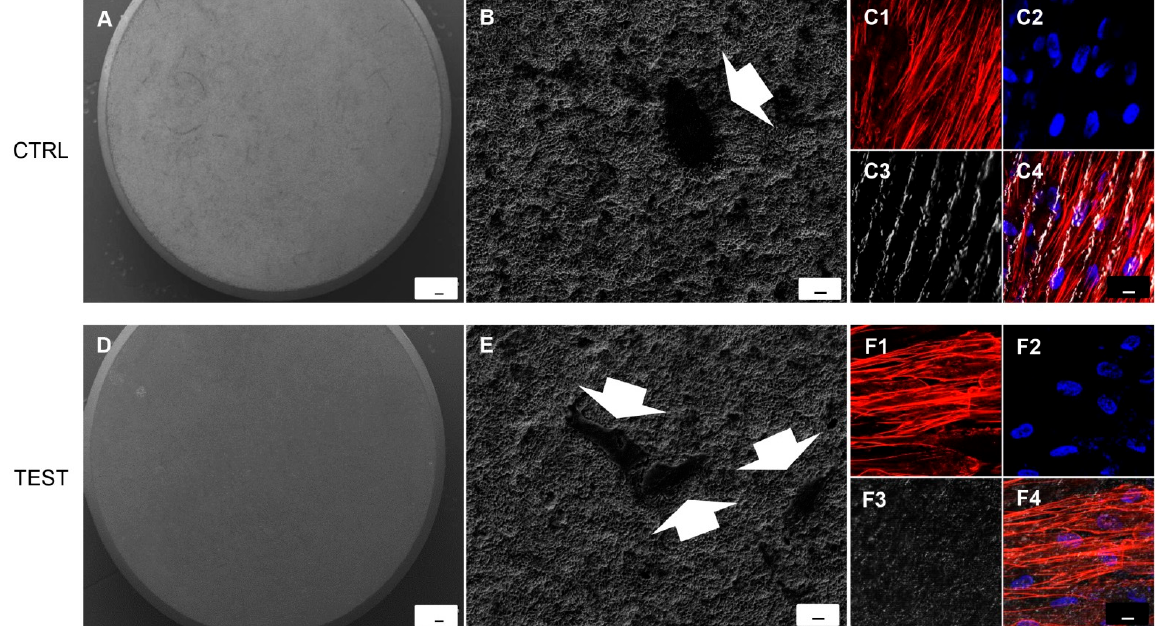
Figure 2. SEM analysis showed the hPDLSCs adhesion capacity to the titanium implant surfaces. ( A ) CTRL surface without cells. ( B ) hPDLSCs adhered on CTRL surface. ( D ) TEST surface without cells. ( E ) hPDLSCs adhered on TEST surface. Arrows indicate the cellular profile. Mag: ( A , D ) 50 × ; ( B , E ) 1000 × . Scale bars: ( A , D ) 100 µ m; ( B , E ) 10 µ m. ( C1 – C4 ) Immunofluorescence images of hPDLSCs cultured on CTRL titanium implant surface. ( F1 – F4 ) Immunofluorescence images of hPDLSCs cultured on TEST titanium implant surface. Mag: 40×. Scale bar: 10 μ m.